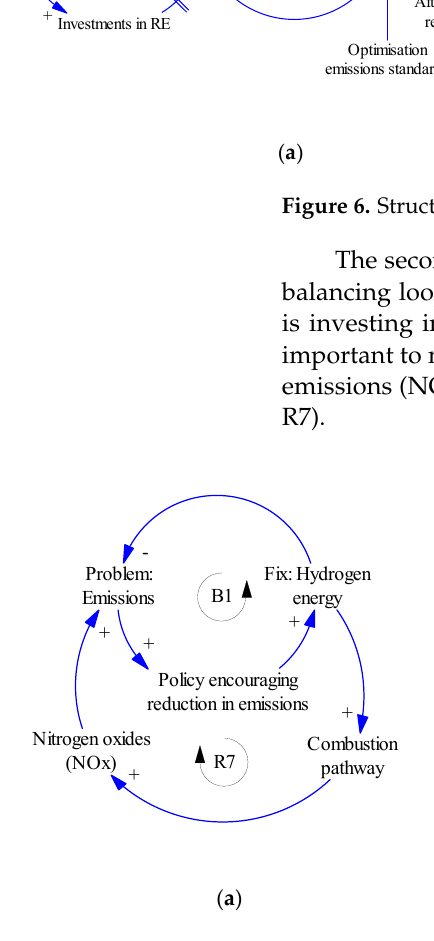
Figure 7. Structure ( a ) and behavioural graph ( b ) of the Fixes that Fail archetype.